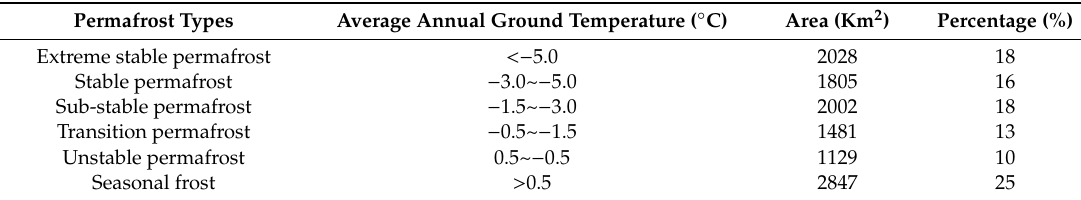
Table 1. The characteristics of di ff erent permafrost types in the source region of Shule River Basin [40].